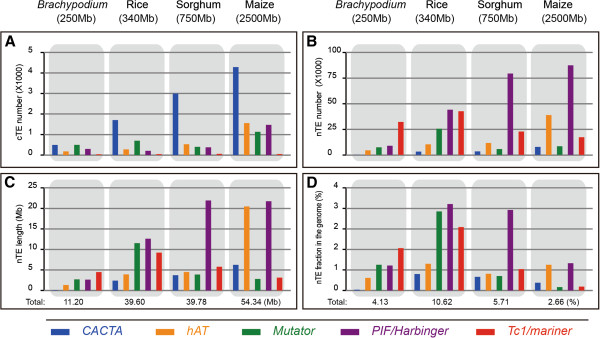
TE annotation results in four grass genomes. Each superfamily is represented by a specific color (CACTA: blue, hAT: dark orange, Mutator: green, PIF/Harbinger: purple and Tc1/mariner: red). A) The number of transposase genes identified by TARGeT. B) Copy number of nTEs. A copy that has only one end was counted as 0.5. C) Total length of nTEs. D) Percentages of nTEs in the genomes.